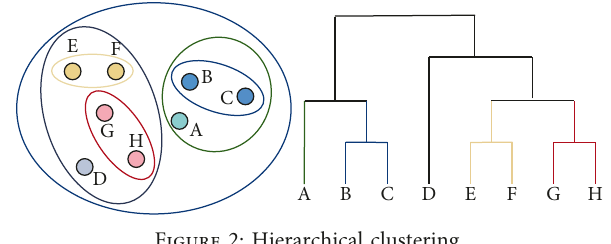
Figure 2: Hierarchical clustering.